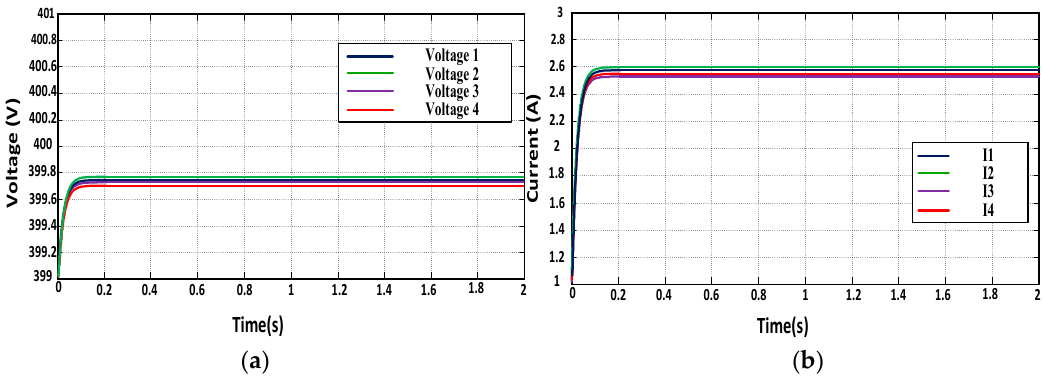
Figure 9. Existing technique [12] with ring communication structure. ( a ) Voltage waveform, ( b ) Current waveforms.